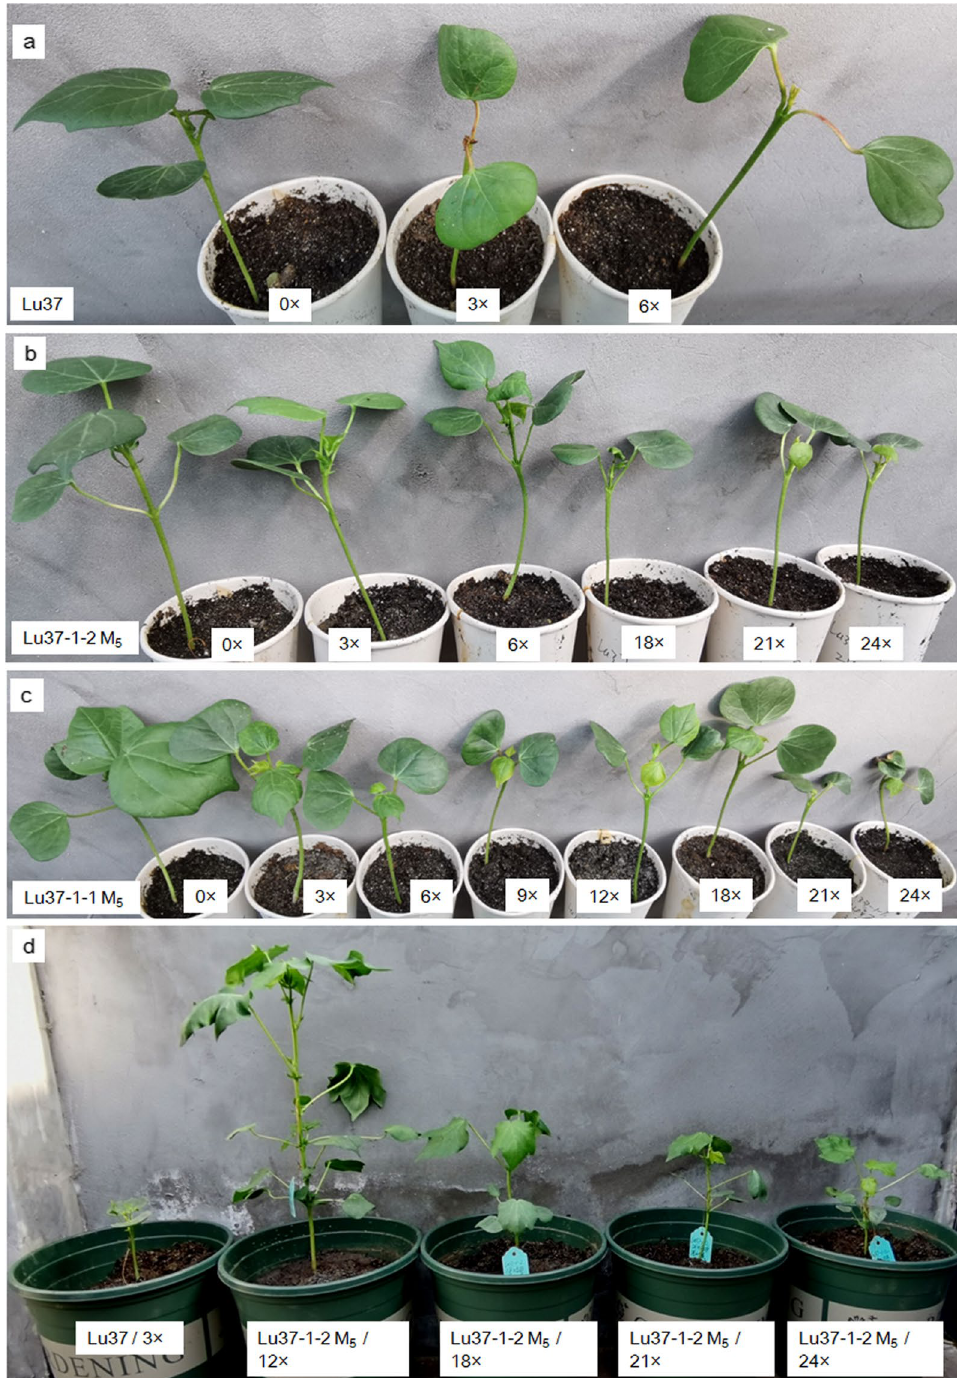
Fig. 2 Greenhouse tests of the herbicide response of the Lu37-1 cotton mutant (M 5 generation) to different doses of imazapic. a At 26 DAT, wild-type Lu37 seedlings under treatment with 3 under treatment with 3 treatment with 3 treatment with 12